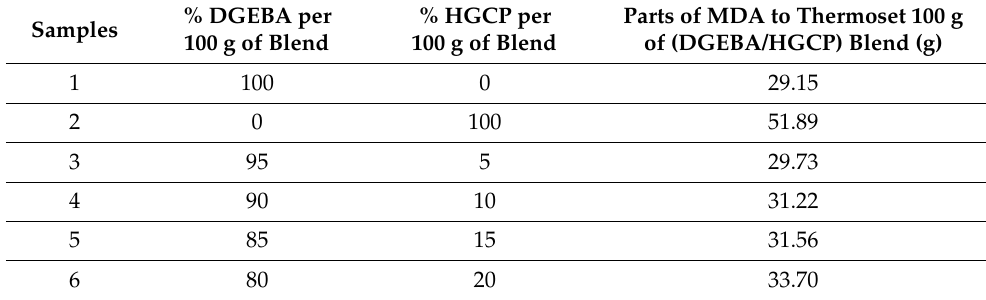
Table 1. Formulations prepared of (DGEBA/HGCP) thermosets with MDA curing agent.